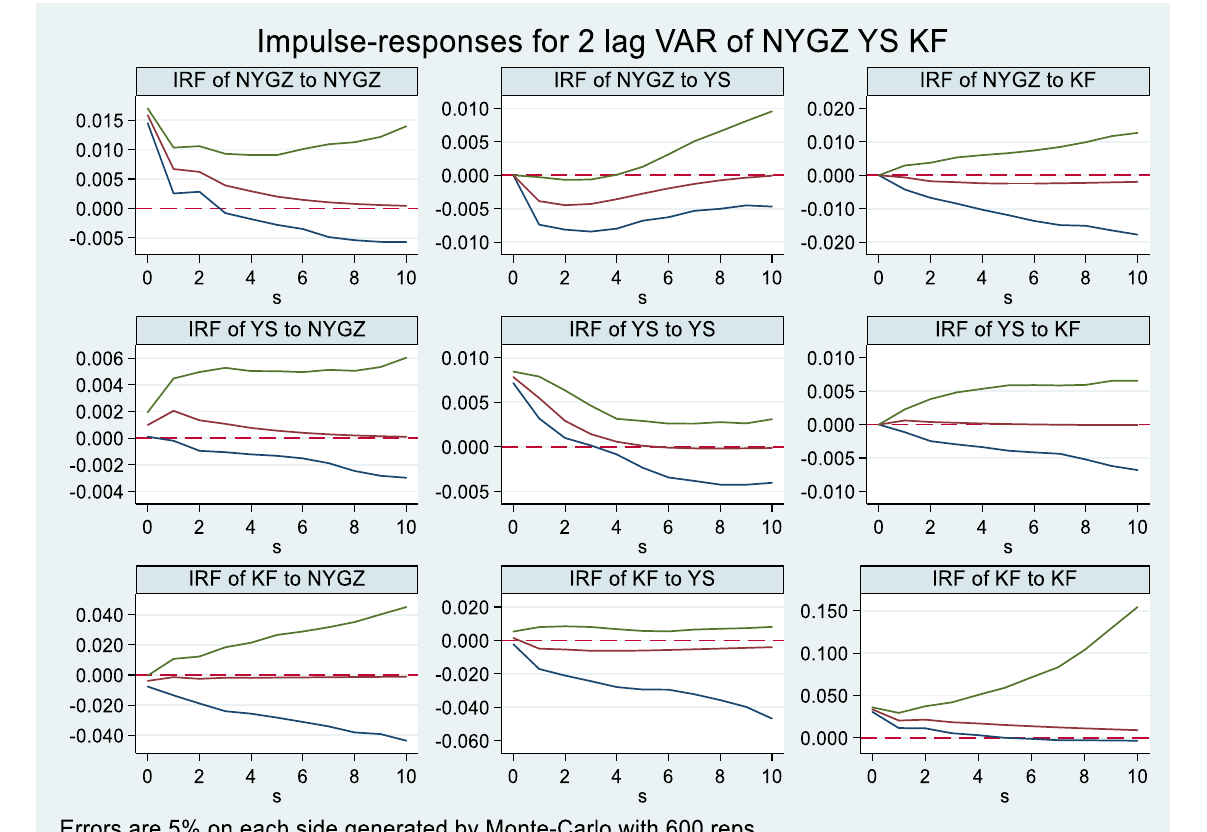
Figure 3. Impulse response diagram of NYGZ, YS and KF.